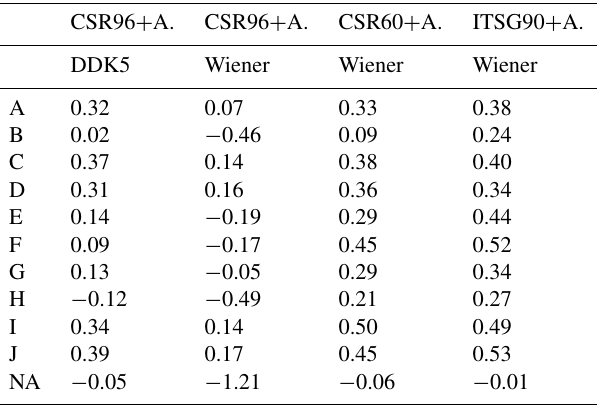
Table 6. Fraction of explained variance, R 2 , of altimetry total sea level by Argo + GRACE steric and mass for different gravity field filter solutions after removing the semiannual and annual signals and the trend. CSR96 + A. CSR96 + A. CSR60 + A. ITSG90 + A. DDK5 Wiener Wiener Wiener A 0.32 0.07 0.33 0.38 B 0.02 − 0.46 0.09 0.24 0.37